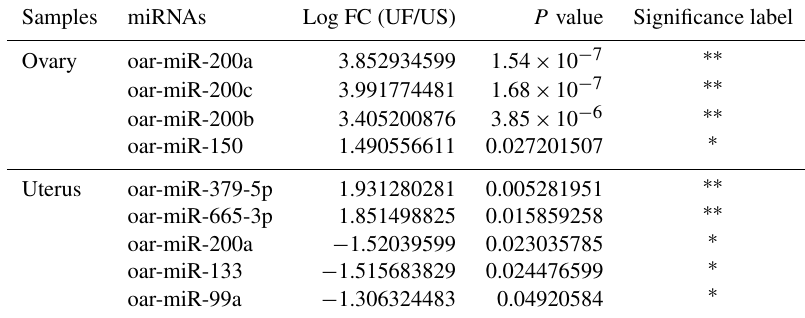
Table 2. The significantly differential expression of known miRNA.